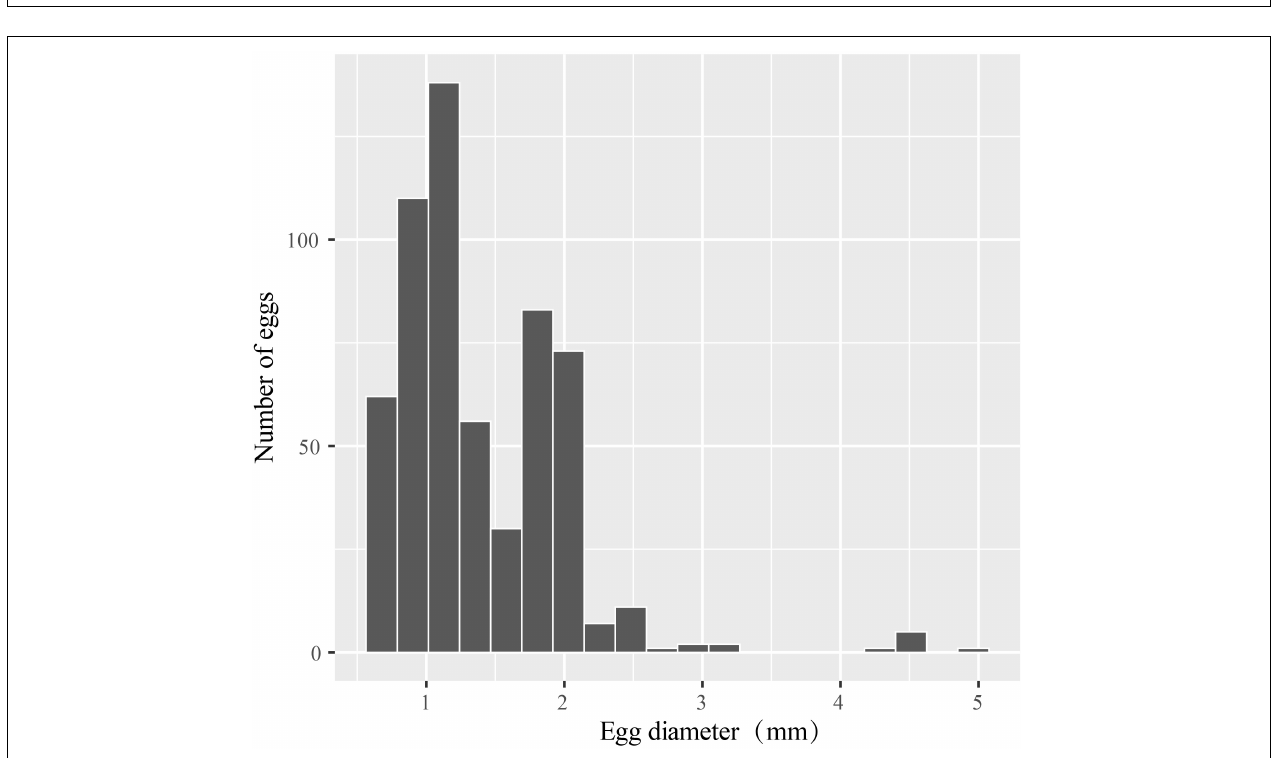
FIGURE 6 | The egg diameter distribution of identified fish eggs in the eastern Beibu